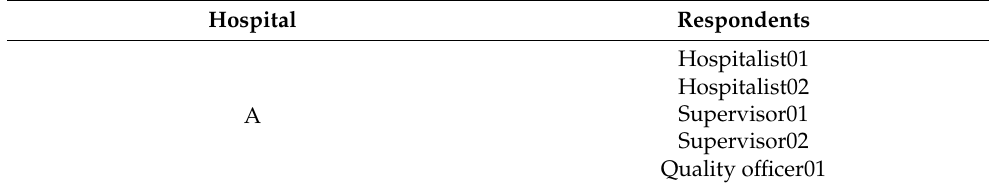
Table 1. Overview of the study